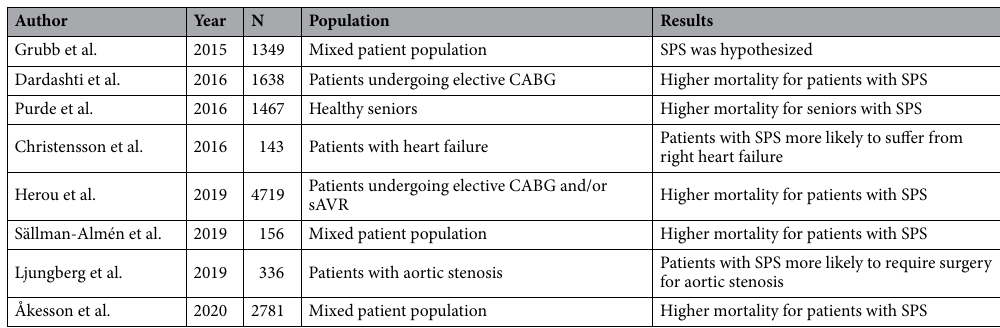
Table 1. Summary of studies on Shrunken Pore Syndrome with clinical outcome